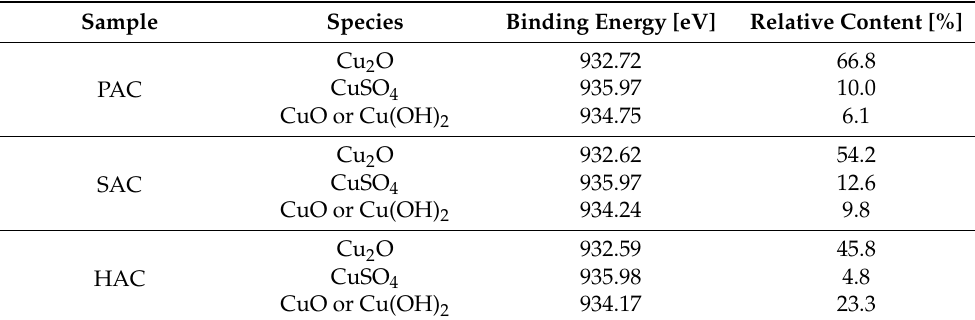
Table 7. The main Cu 2p photopeaks of PAC, SAC and HAC activated biocarbons.